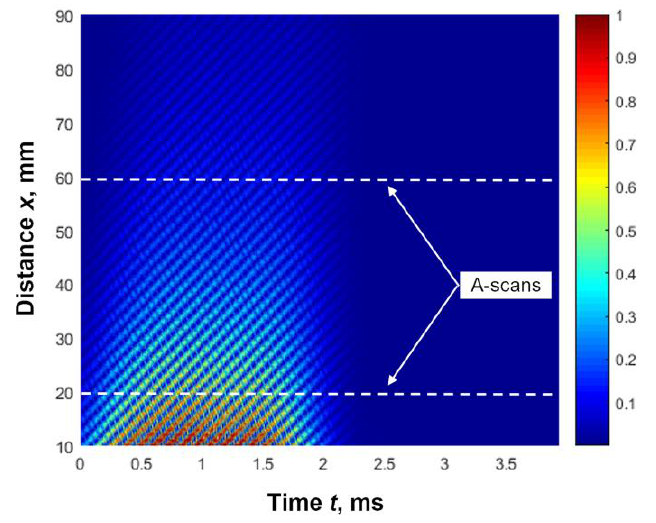
Figure 11. Measured B-scan of the normal displacement of the PVC film.